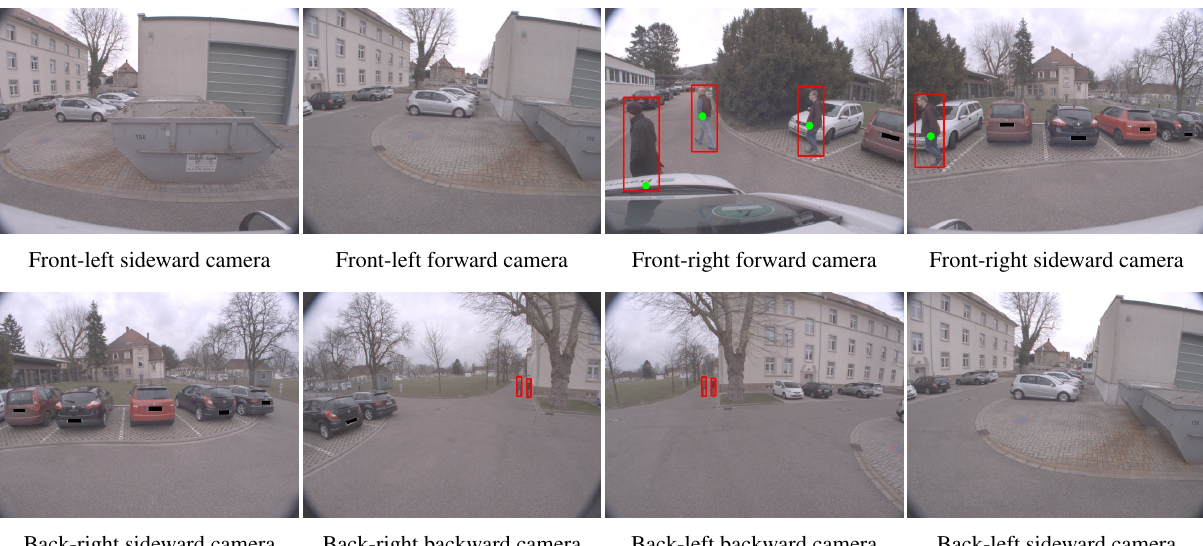
Figure 4. Pedestrian detection of five people using the panoramic cameras (red bounding boxes) and LiDAR-sensors (green dots) of MODISSA.